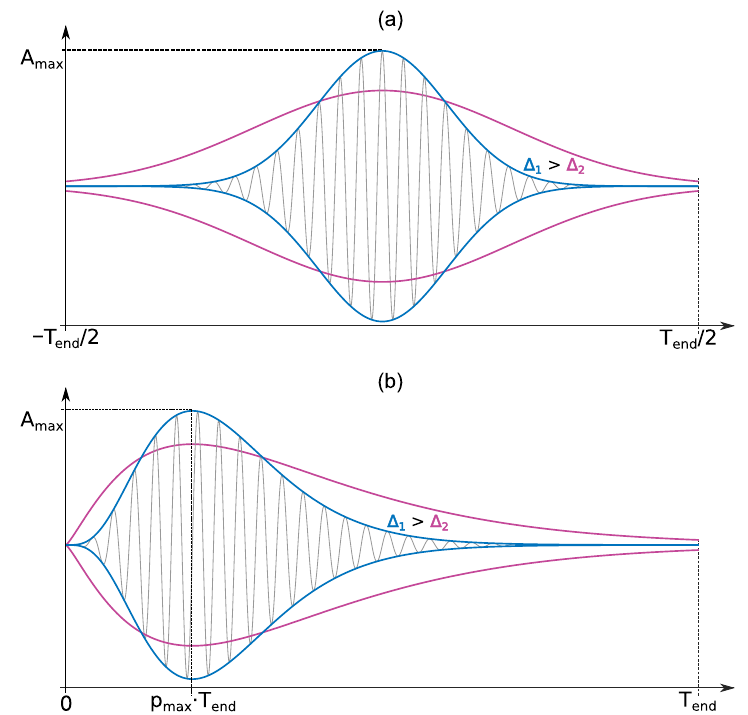
Figure 2. Effect of the parameters T end , p max and ∆ on the form of functions: ( a ) Gaussian function, ( b ) Berlage